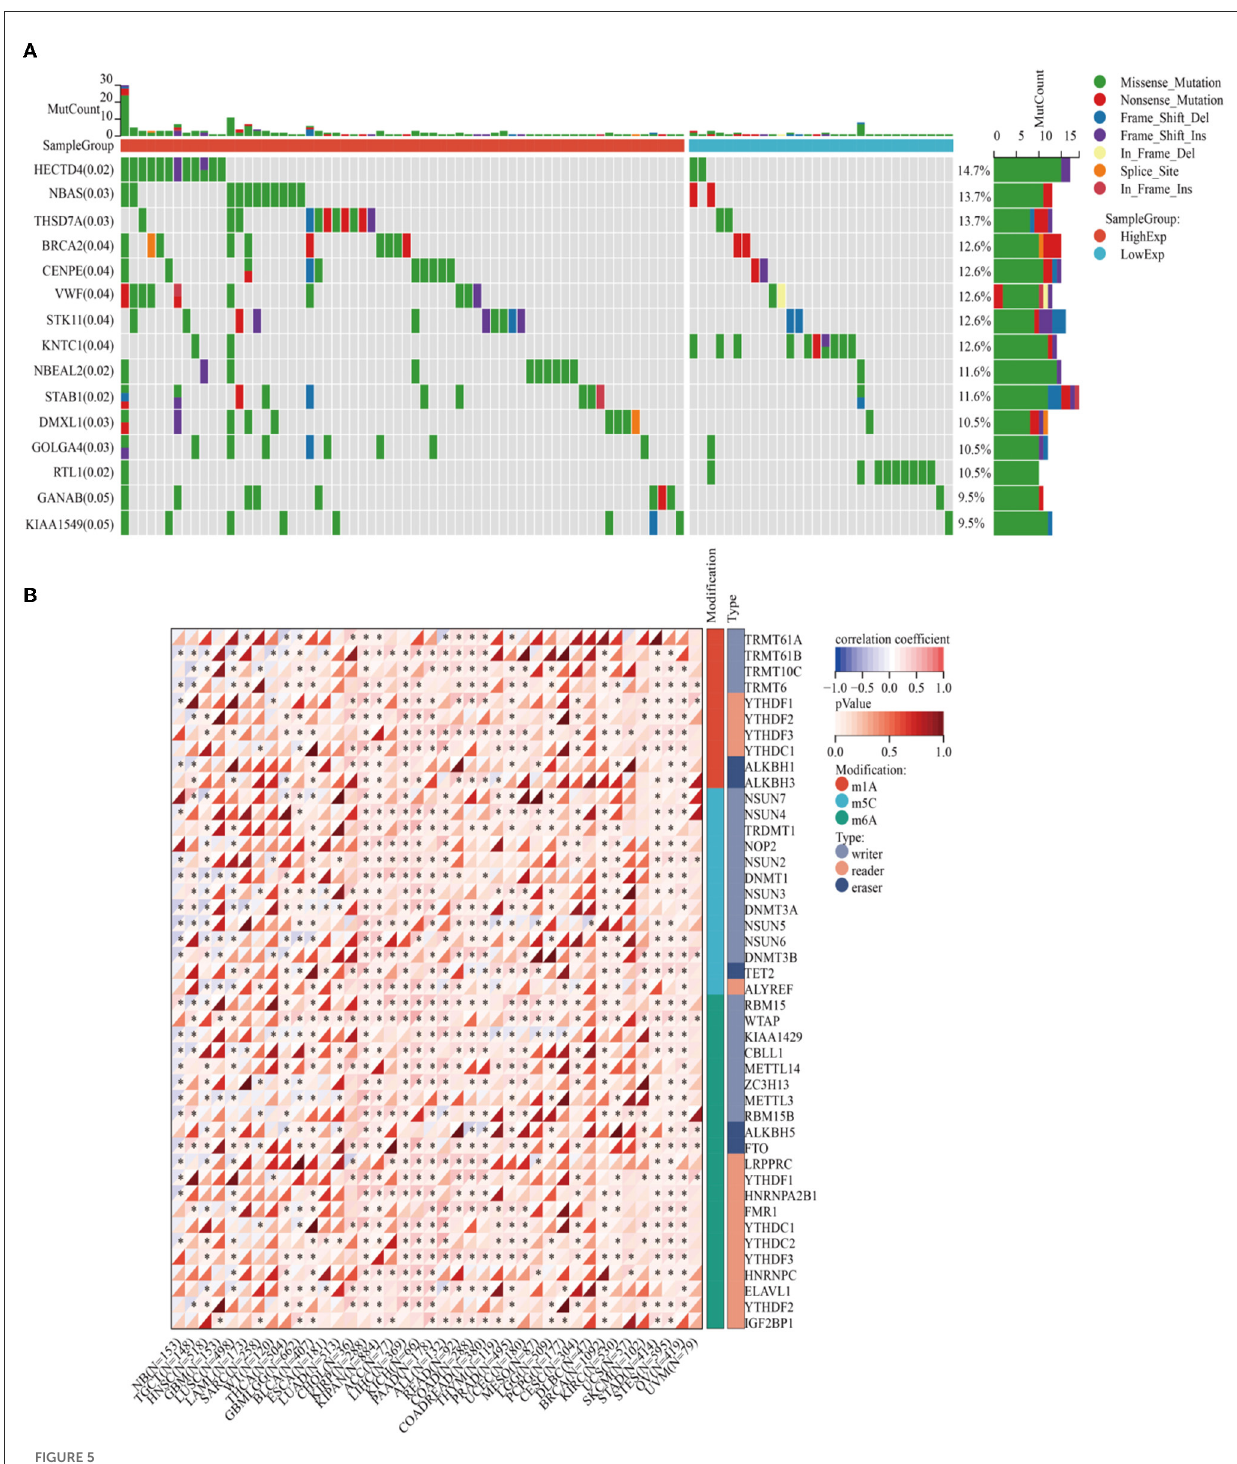
FIGURE5 Genetic alteration analysis and RNA methylation analysis of EREG in cervical cancer. (A) The waterfall plot represents the genetic mutation discrepancies in a different expression of EREG in cervical cancer. The annotations in parentheses behind the gene symbol represent the p -value of the mutation discrepancy. (B) The map represents the relationship between EREG expression and the distribution of crucial RNA methylation modification genes. “*” represented p < 0.05, which indicated statistical